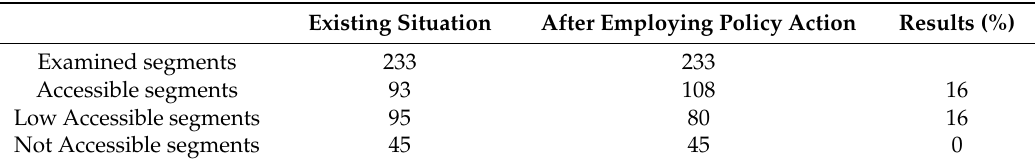
Table 5. The results of the policy change “2” on the accessibility. Existing Situation After Employing Policy Action Results (%)